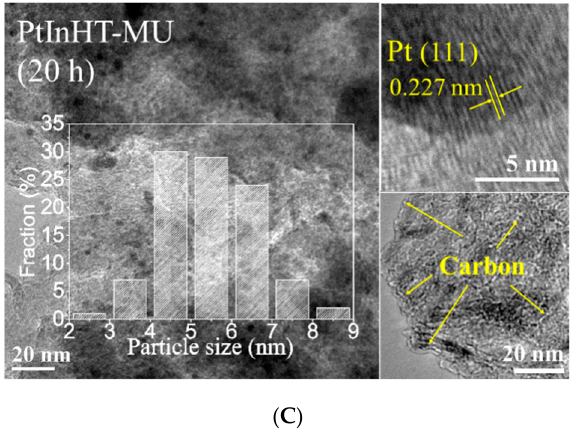
Figure 10. TEM images, HR-TEM and the statistics of particle size distributions in the insets of the used catalysts with different reaction times. ( A ) 190 h, ( B ) 50 h and ( C ) 20 h.